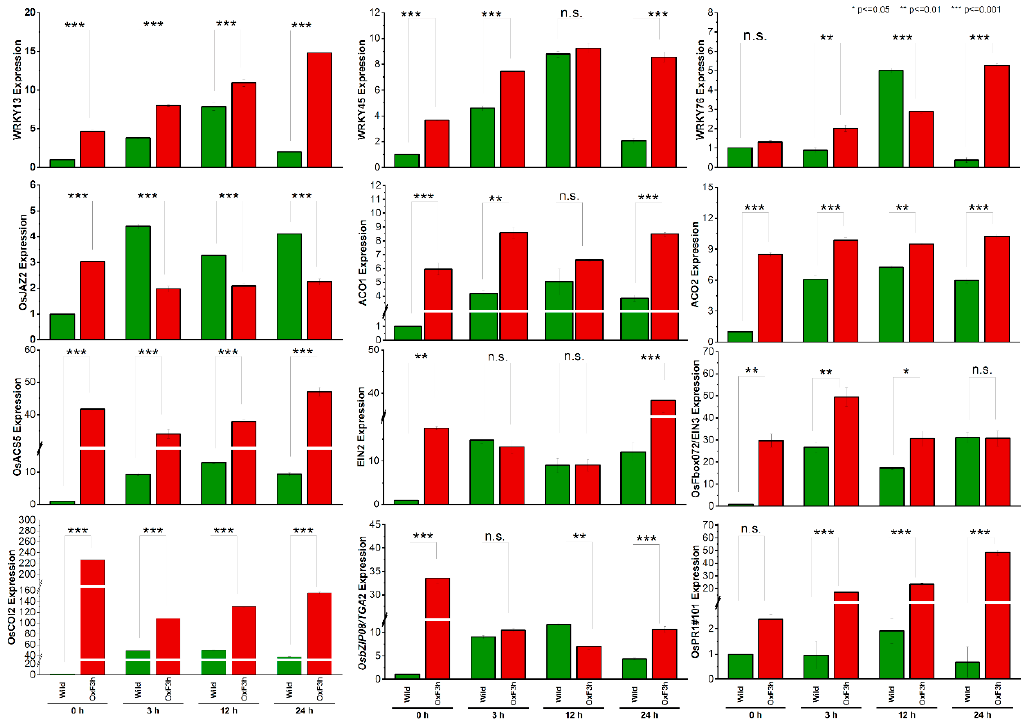
Figure 6. Validation of relative expression of selected genes in wild type and OxF3H plants under WBPH infection, by qRT-PCR. The fold change of each gene was calculated at different time points (0 h, 3 h, 12 h, and 24 h). Graphs show mean ± standard deviation of three biological replicates, and asterisks show significant differences (* p ≤ 0.05, ** p ≤ 0.01, and *** p ≤ 0.001) according to ANOVA and Bonferroni post hoc tests. n.s. mean non significant.